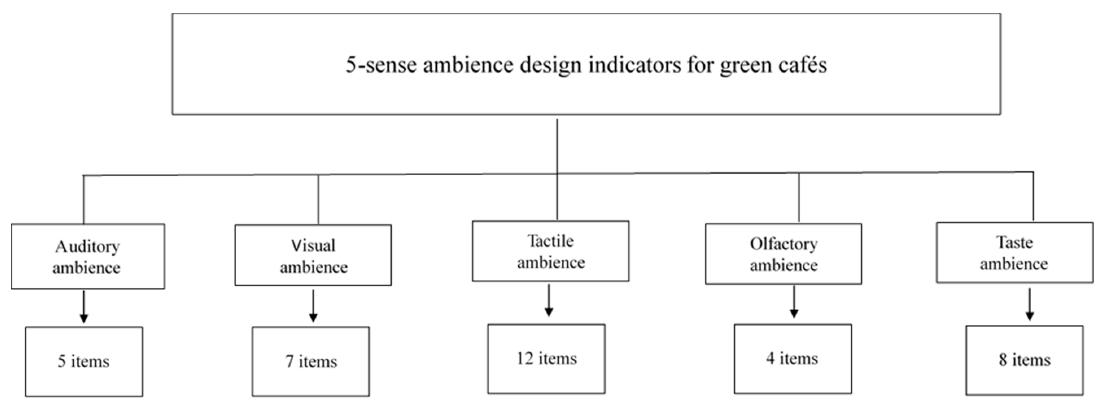
Figure 2. Indicators for green café ambience design.